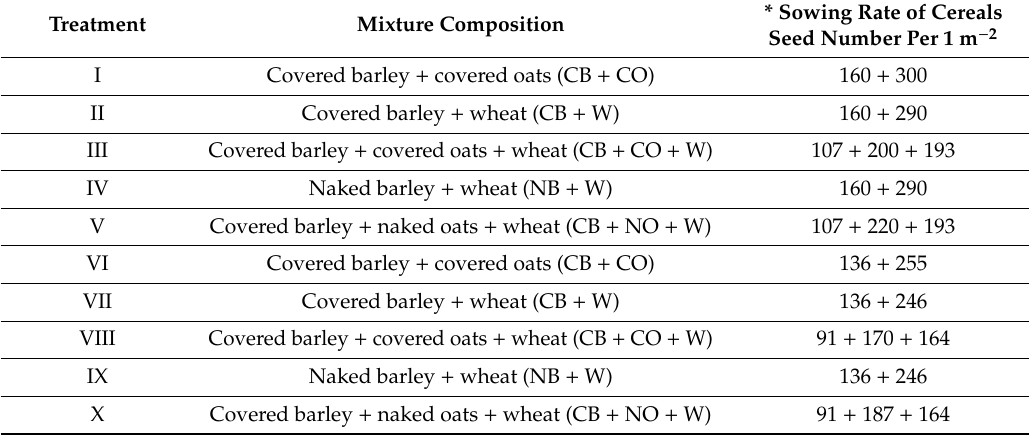
Table 2. Experimental scheme with spring cereal